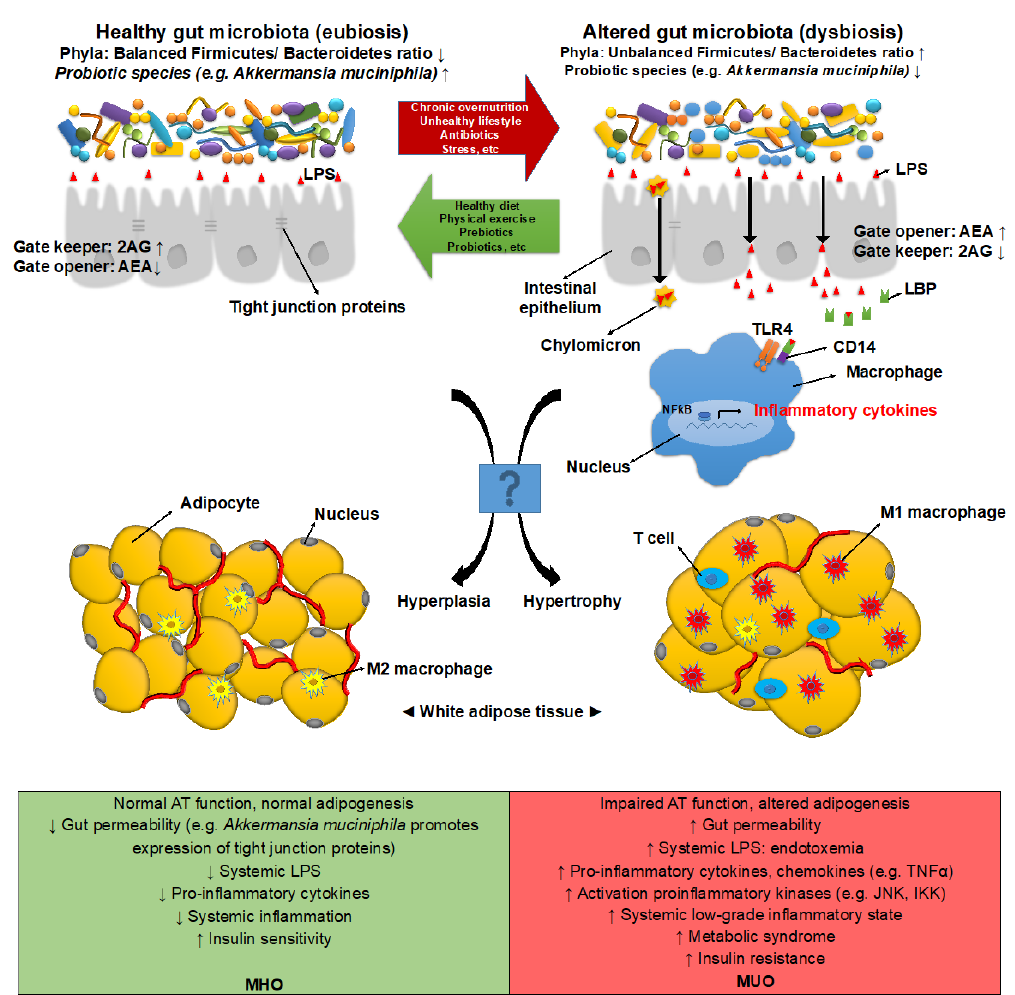
Figure 1. Imbalances in the composition of the gut microbiota can lead to an altered gut-barrier function, and are often observed in several conditions including obesity, related metabolic disorders, and type 2 diabetes. A dysfunctional or “leaky” intestinal tight junction barrier allows augmented translocation of luminal gut-microbiota-derived components, such as LPS, into the blood stream. Increased circulating LPS levels activate the pattern recognition receptor TLR4 and trigger proinflammatory and oxidative cascades that contribute to insulin resistance, macrophage infiltration, secretion of pro-inflammatory cytokines, and lipid accumulation in several organs and tissues, including the AT. The probiotic Akkermansia muciniphila preserves the integrity of intestinal barrier function and reduces endotoxemia, possibly by regulating expression of endocannabinoids such as 2AG (augmented), which has been considered as a “gate keeper”, and AEA (decreased), considered a “gate-opener”. During obesity, AT expansion can be mediated by hypertrophy, hyperplasia, or both. MHO individuals are associated with an enhanced adipogenic capacity in comparison to MUO, therefore hyperplasia could potentially be the preferred expansion mechanism of fat tissue in the former individuals. The molecular mechanisms controlling both hyperplasia and hypertrophy have not been fully disclosed so it would be of interest to explore if microbiota and gut-barrier function have any role in regulating the AT expansion during obesity and if this could explain the distinct health profile between MHO and MUO. 2AG, 2-arachidonoylglycerol; AEA, anandamide; AT, adipose tissue; CD14, cluster of differentiation 14); IKK, I kappa B kinase; JNK, c-Jun N-terminal